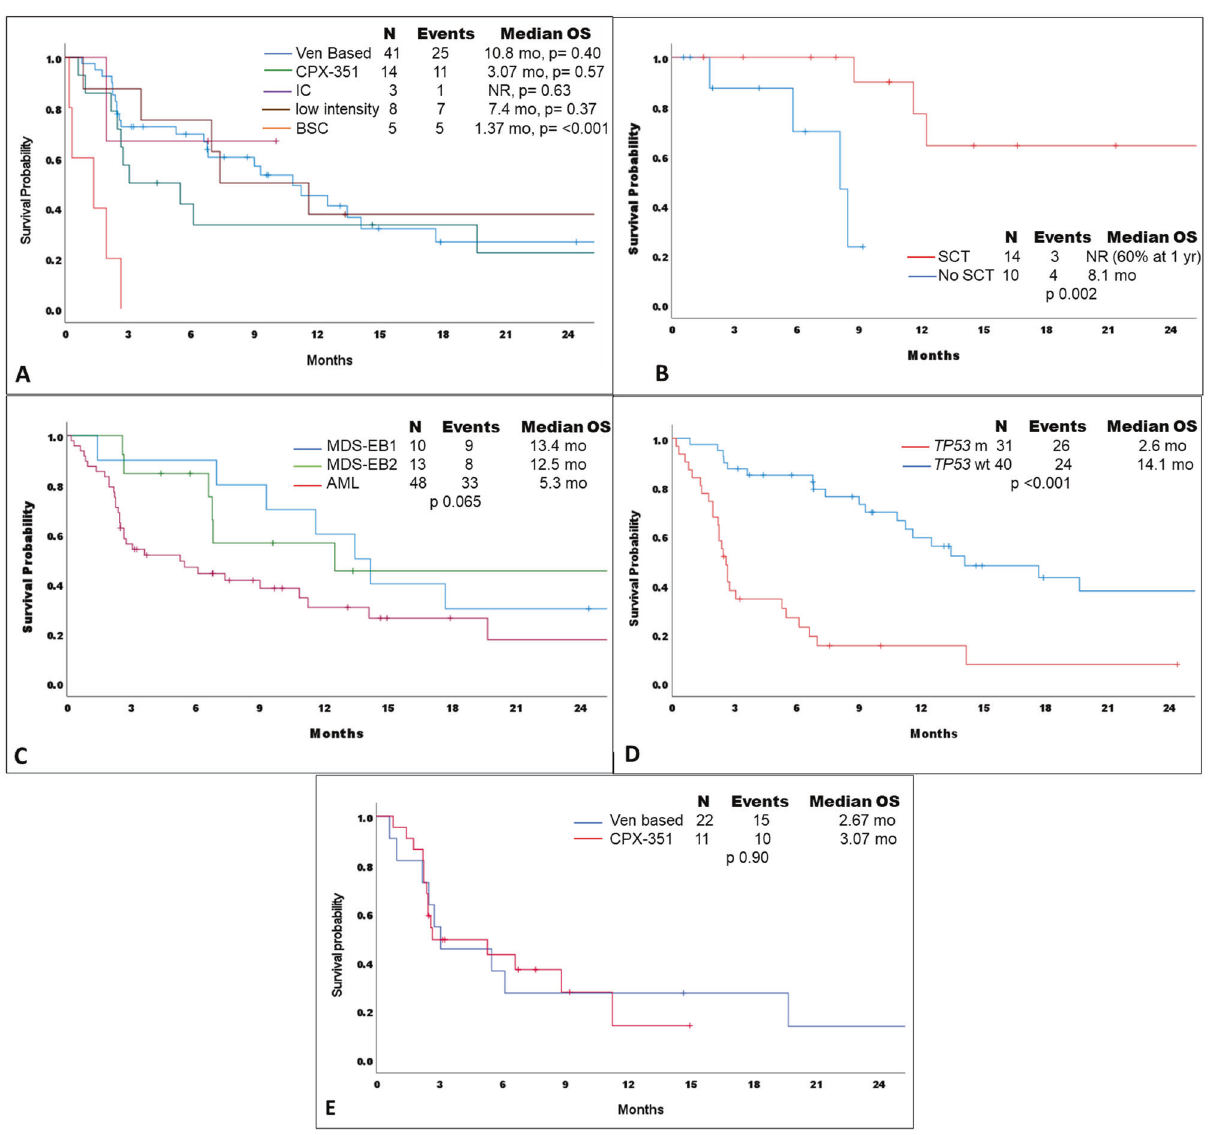
Fig. 1 Survival outcome of patients with myelodysplastic syndrome (MDS) progressing on hypomethylating agents (HMA). ( A ) Kaplan Meier survival curve after HMA progression based on different therapies, ( B ) in patients with complete remission (CR) receiving stem cell transplantation (SCT) vs patient in CR and no SCT, ( C ) in MDS-EB1, MDS-EB2 and AML ( D ) in TP53 mutated patients ( E ) in patients with TP53 mutated and/or complex cytogenetics receiving HMA/low dose cytarabine (LDAC) plus venetoclax versus